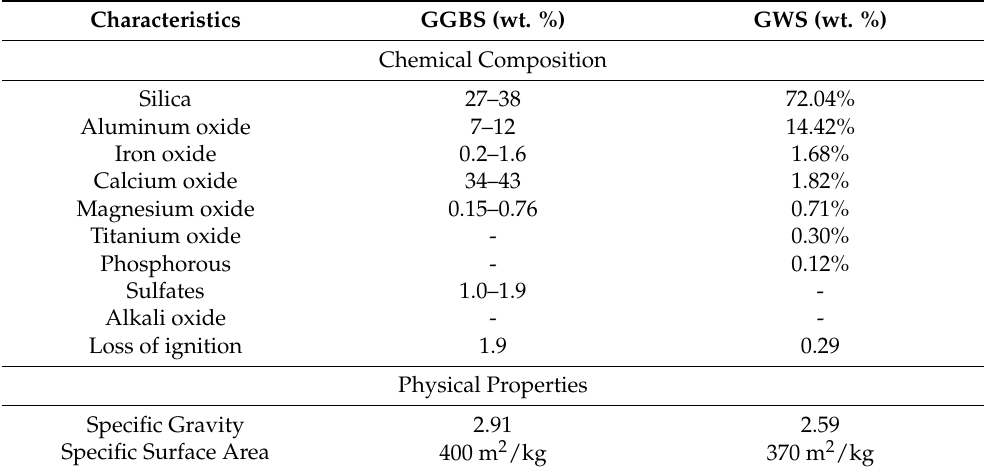
Table 1. Chemical composition and physical properties of GGBS and GWS. Characteristics GGBS (wt.